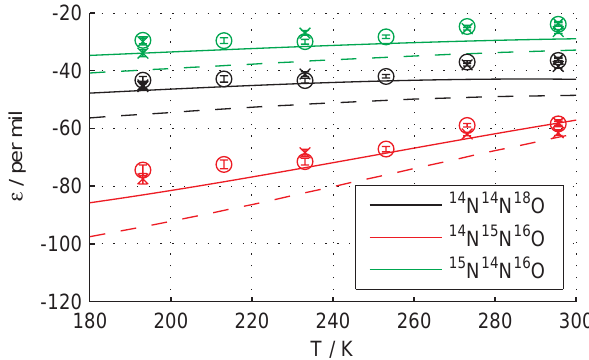
Fig. 7. The Sb-lamp fractionation constant vs. temperature. The fractionation constants of this study are calculated using Eqs. (1) and (4). Broken and solid lines are the results of this study with and without 207nm filter respectively, while ◦ and × mark the exper- imental data of Kaiser et al. (2002) also with and without 207nm filter